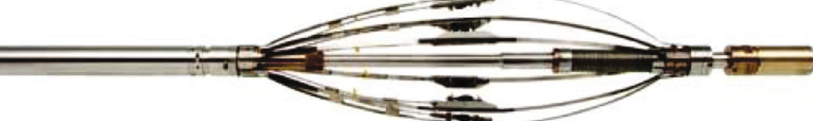
Figure 2: MAPS+CFB.